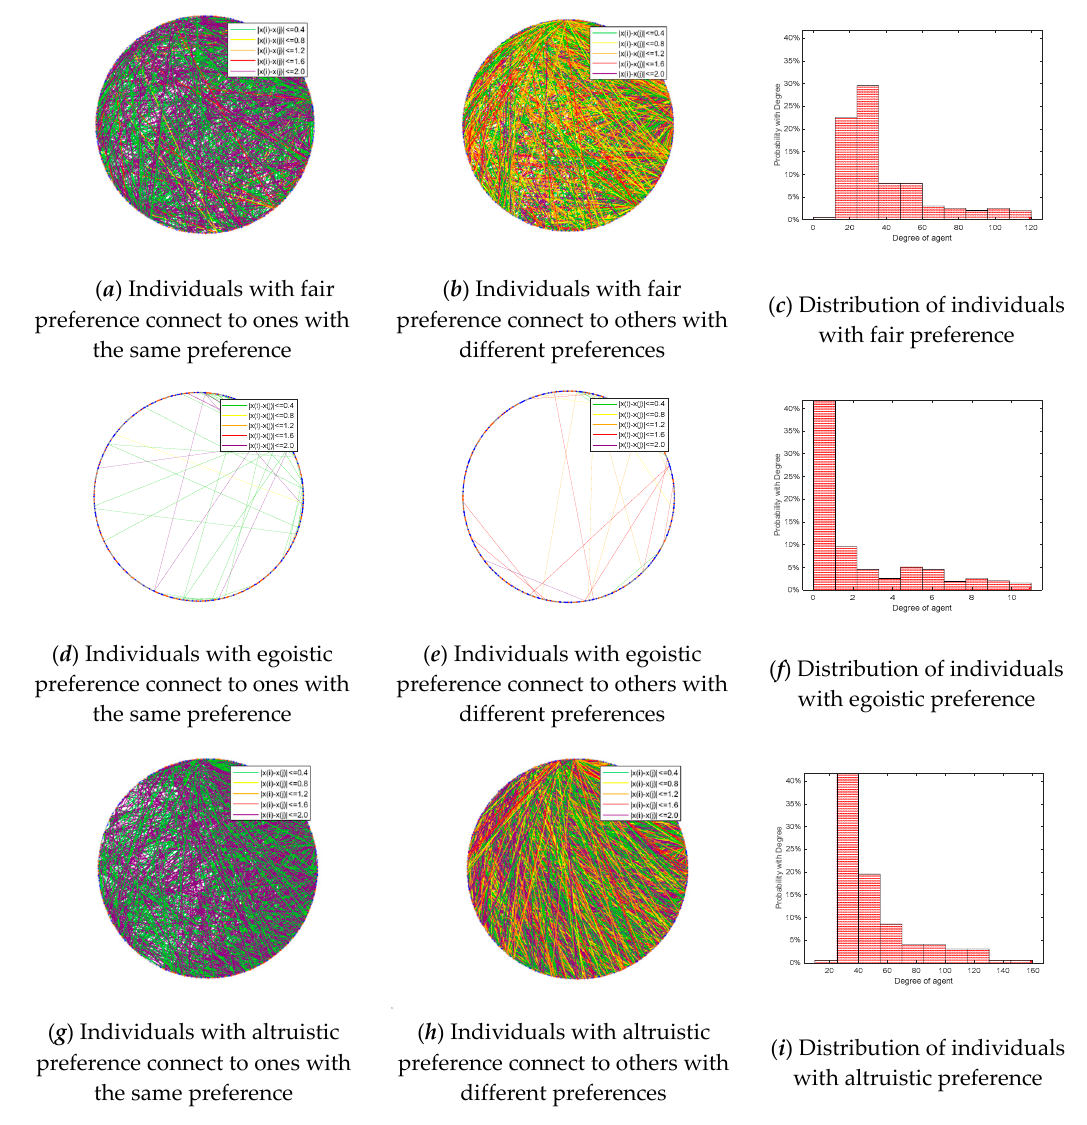
Figure 19. Connections of three different preferences and distribution.